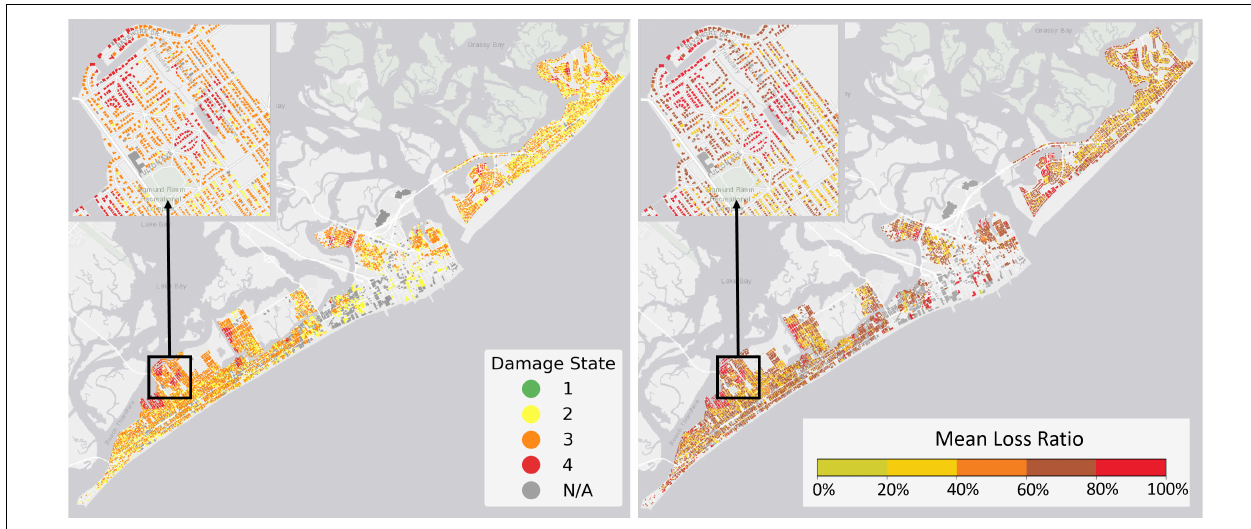
FIGURE 8 | Atlantic City testbed for category 5 hurricane wind scenario: damage states (left) and mean loss ratio (right) .